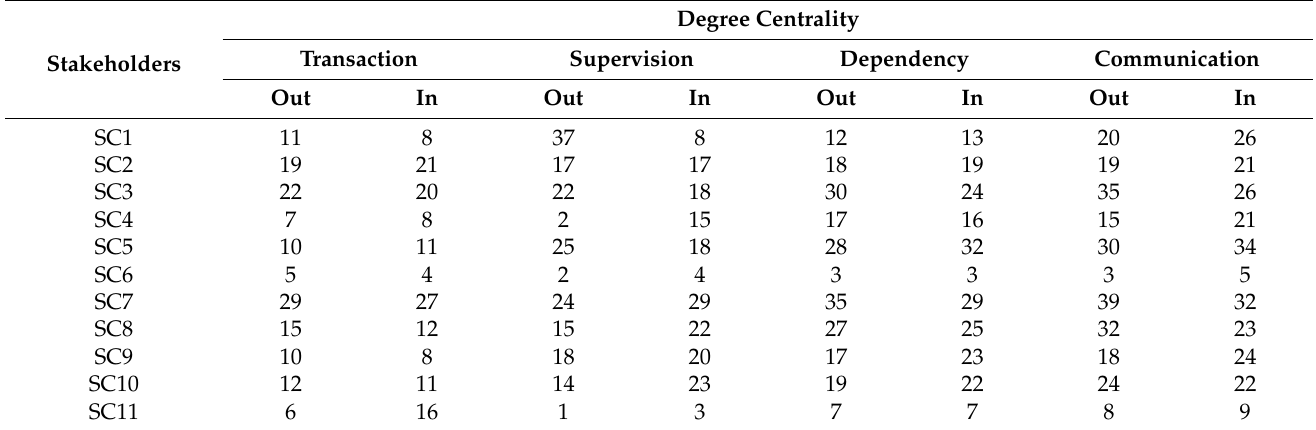
Figure 6. Network of four relationship: ( a ) Transaction; ( b ) Supervision; ( c ) Dependency; ( d ) Communication. Table 10. Centrality analysis of the four-dimensional relationship network.